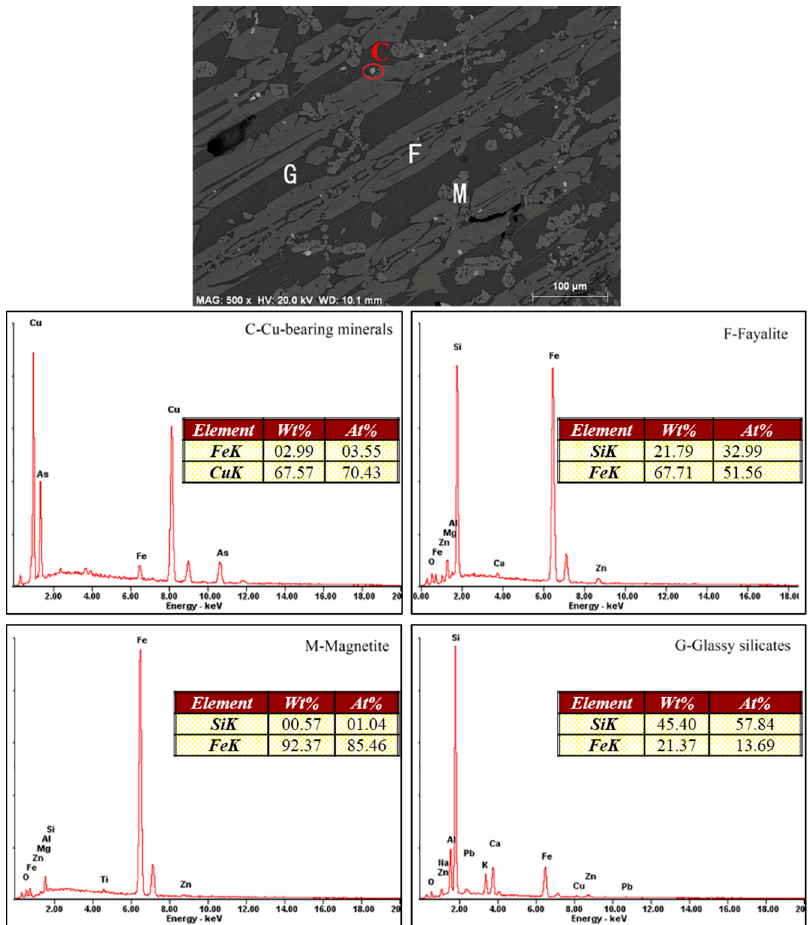
Figure 2. SEM – EDS results of the sample (C — Cu-bearing minerals, F — Fayalite, M — Magnetite, G — Glassy silicates).